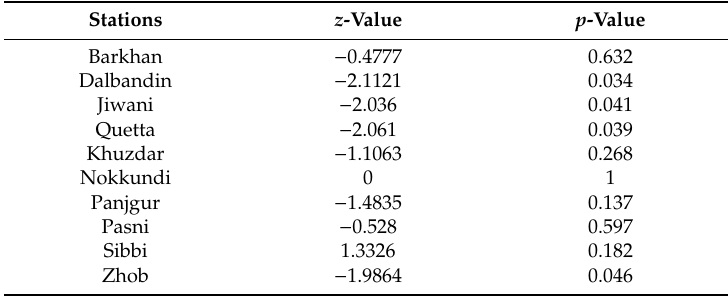
Table 2. Results of Mann-Kendall trend